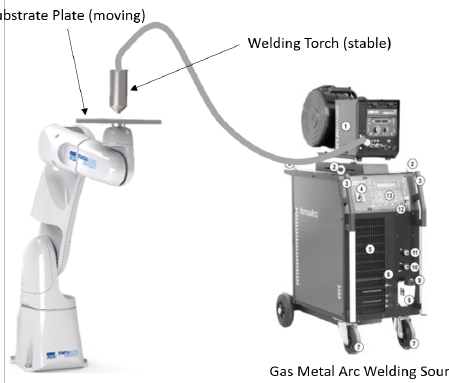
Figure 8. GMAW based WAAM process with pure object